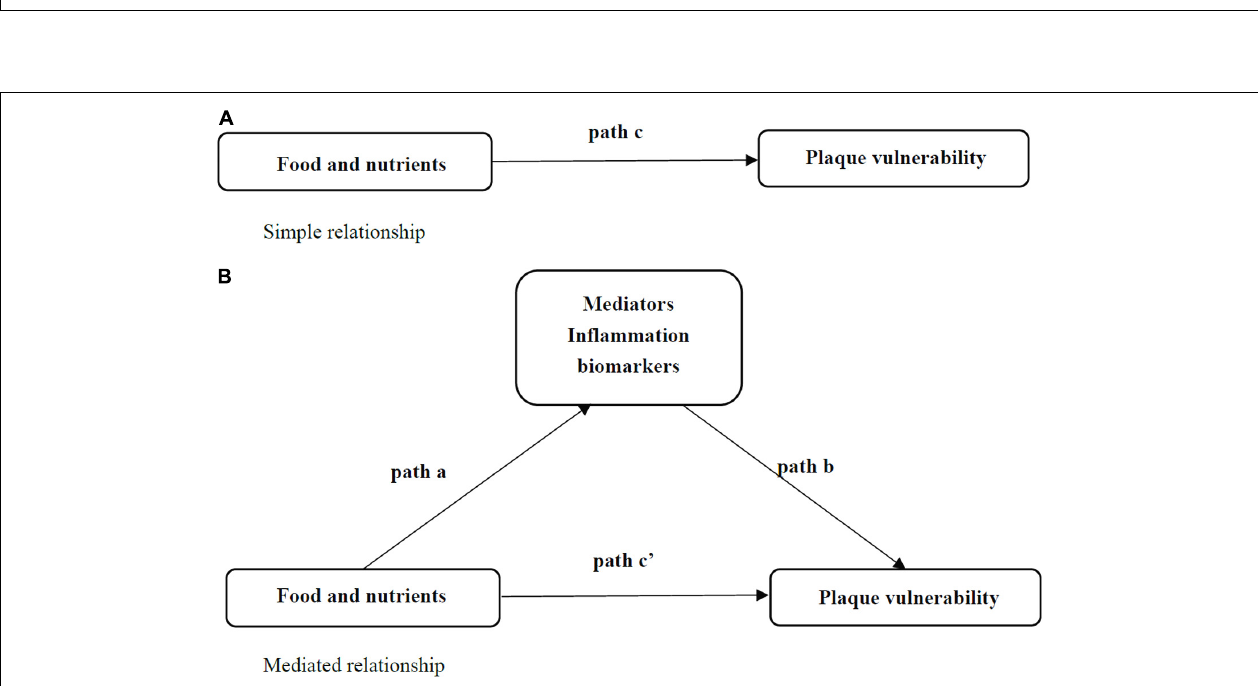
Frontiers in Nutrition |